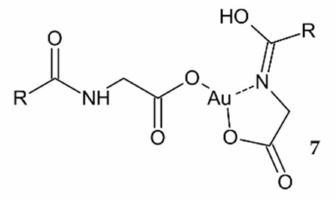
Figure 4. A new bile acid cholylglycinato Au(III) complex 7